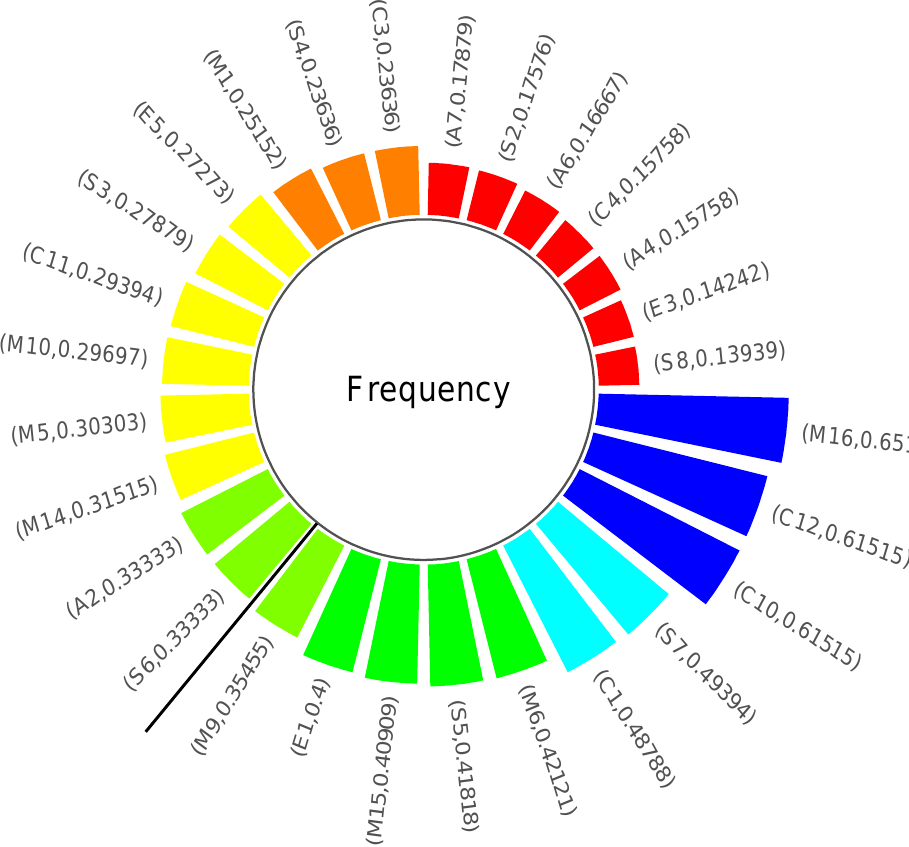
Figure 15. The frequency statistics of safety risk factors.